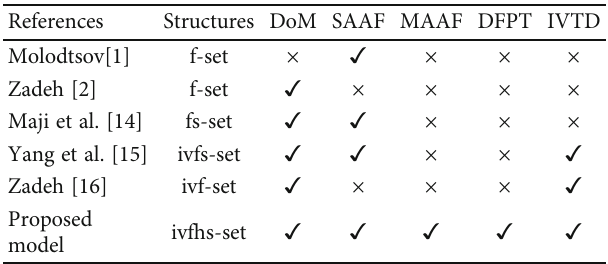
Table 6: Structural comparison of proposed structure with existing relevant